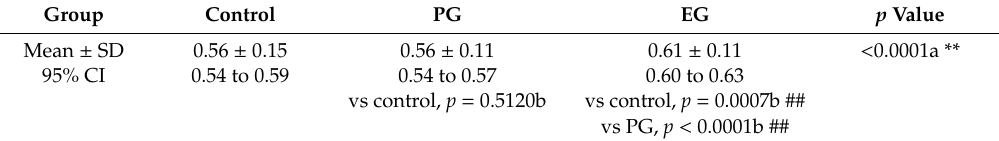
Table 2. Comparisons of advanced glycation end products among three groups.